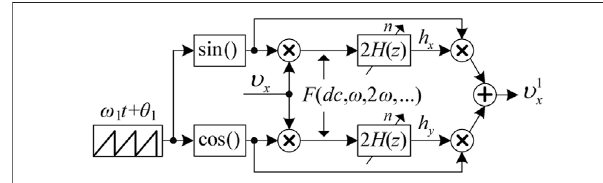
FIGURE 2 | Detection of the fundamental voltage.